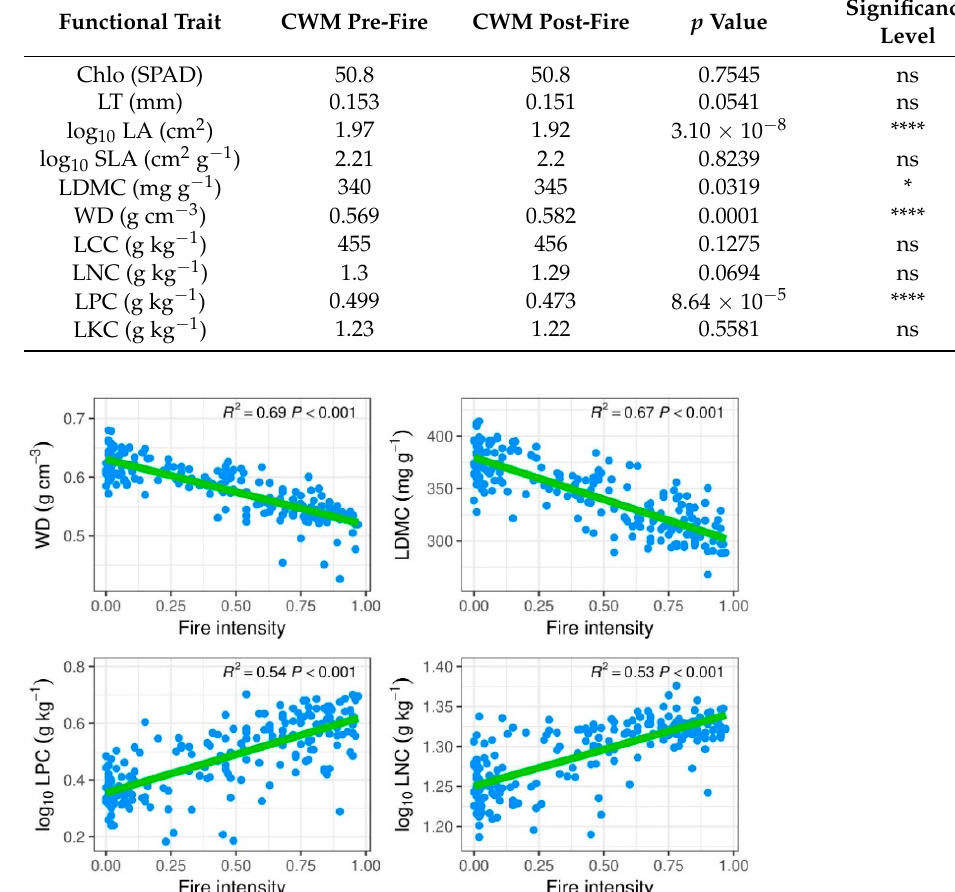
Figure 7. Simple linear regression analyses between community-weighted mean (CWM) of functional traits and fire intensity in Huai Kha Khaeng Forest Dynamics Plot, Thailand. WD, wood density; LDMC, leaf dry matter content; LPC, leaf phosphorus concentration; LNC, leaf total nitrogen